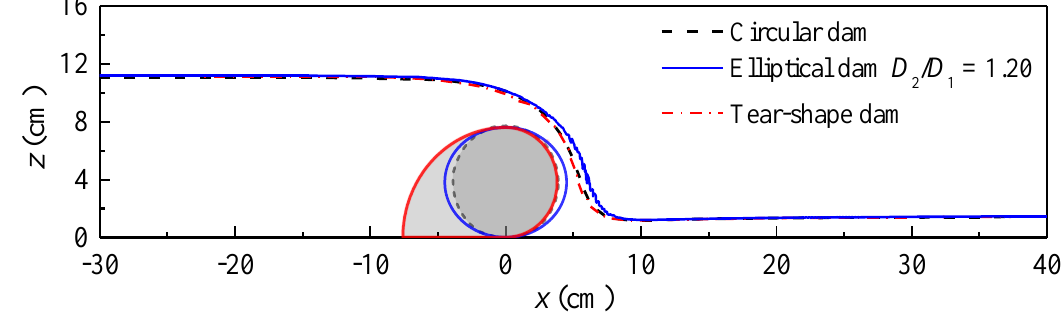
Figure 14. Comparison of the simulated water depths for the circular, elliptical, and tear-shape dams.